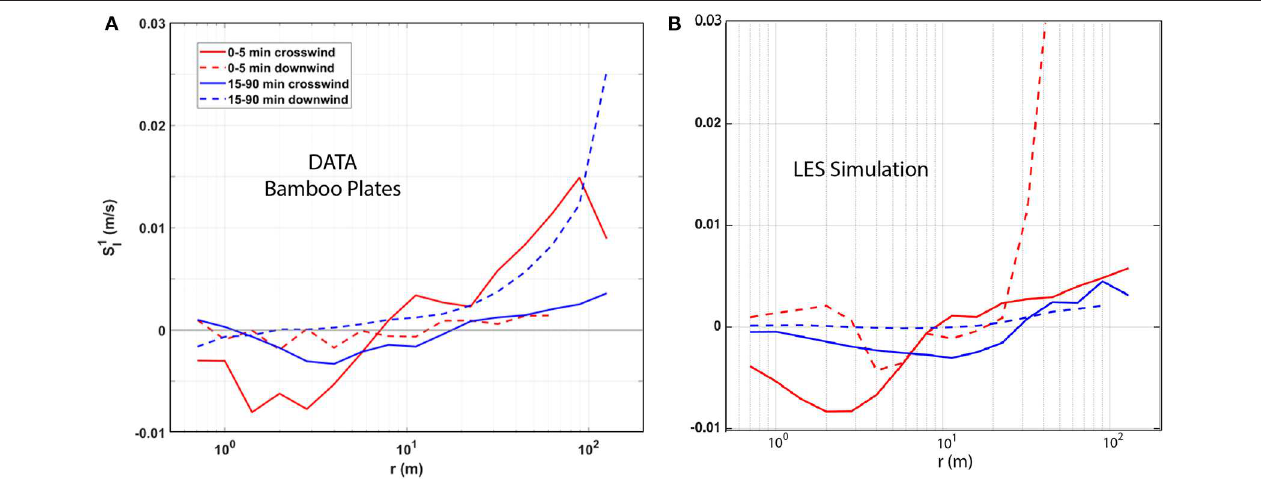
FIGURE 12 | Longitudinal first order structure function Sl1 for crosswind (solid) and downwind (dashed) separations sampled at early (red) and late (blue) times. Times for each are given in the caption relative to the start of the measurements. (A) Data from tracked bamboo plates (from Chang et al., 2019). (B) LES simulation of